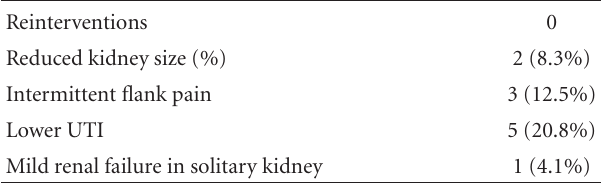
Table 2: Complications and